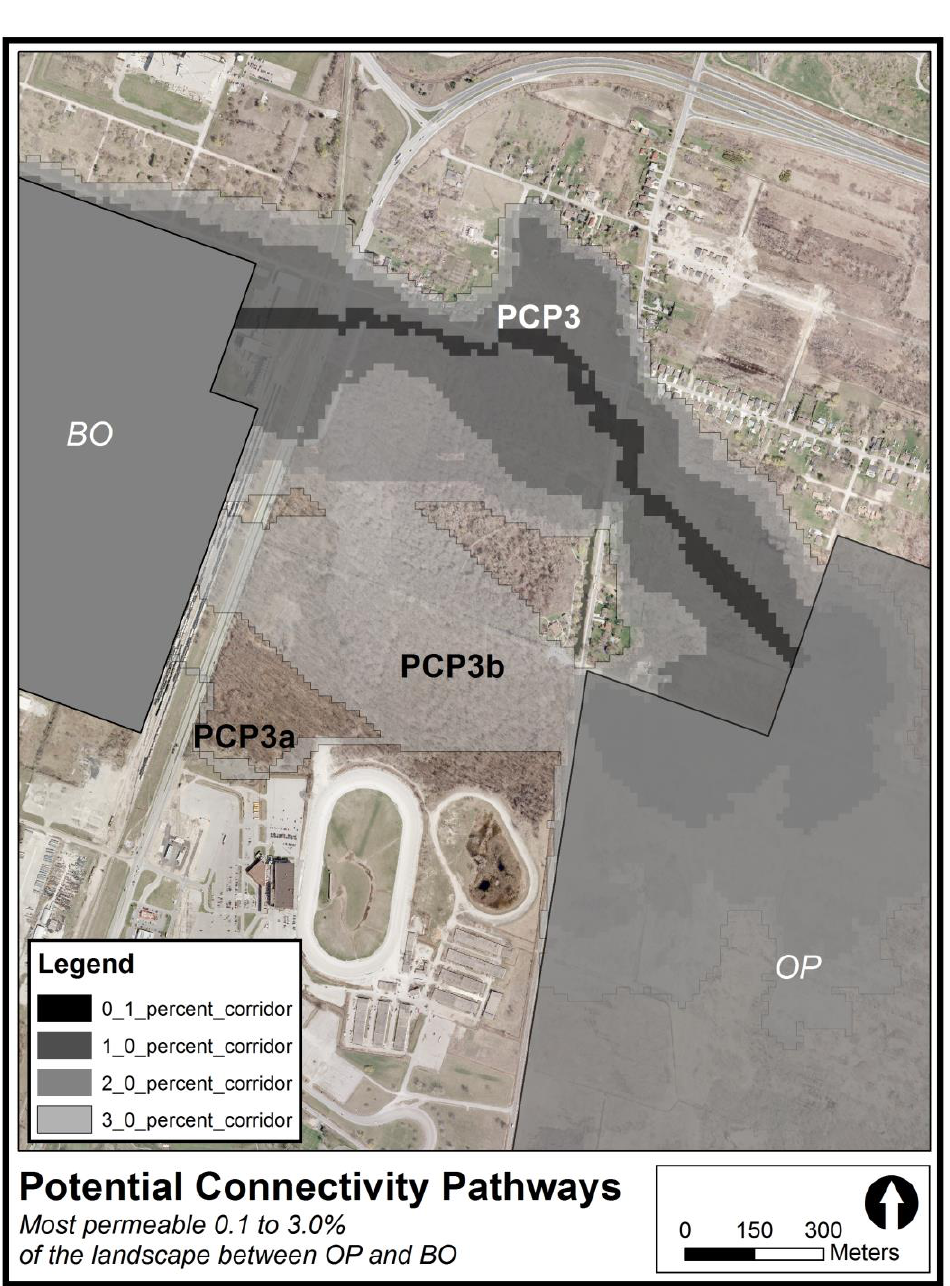
Figure 8. The most permeable 0.1% to 3.0% of the landscape between Ojibway Prairie (OP) and Black Oak Heritage Park (BO) for the Massasauga rattlesnake in Windsor/LaSalle, Ontario as indicated by a cost-surface GIS analysis.